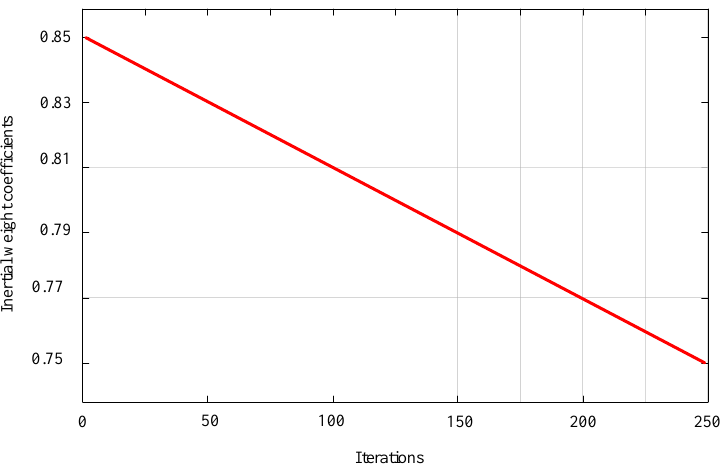
Figure 1. The relation curve of inertial weight and iterations under linear decreasing.